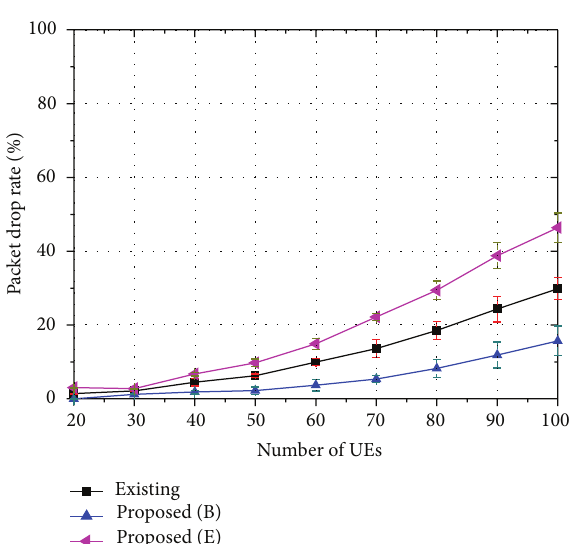
Figure 4: Packet drop rate of 8-viewpoint 3D A/V traffic ( 𝛽 = 0.45